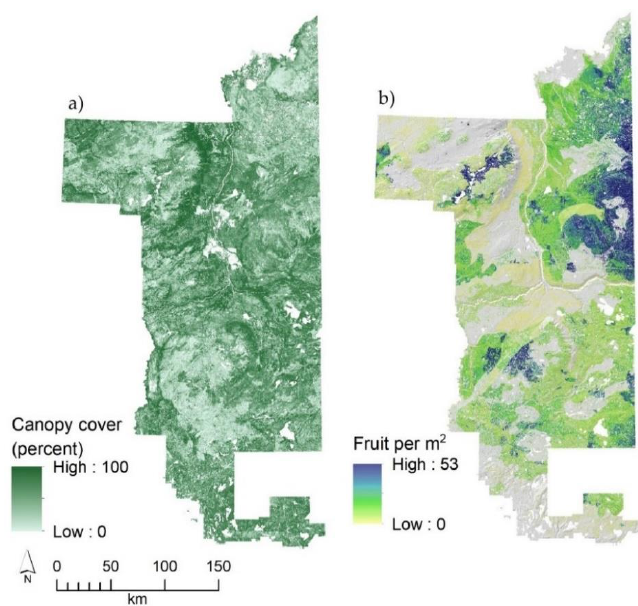
Figure 4. Predicted average fruit production (berries/m 2 ) of velvet-leaf blueberry as a function of forest canopy cover measured from Airborne Laser Scanning (ALS) data (fraction of first returns at >1.37 m height) and blueberry shrub cover. All other variables were held at their mean.